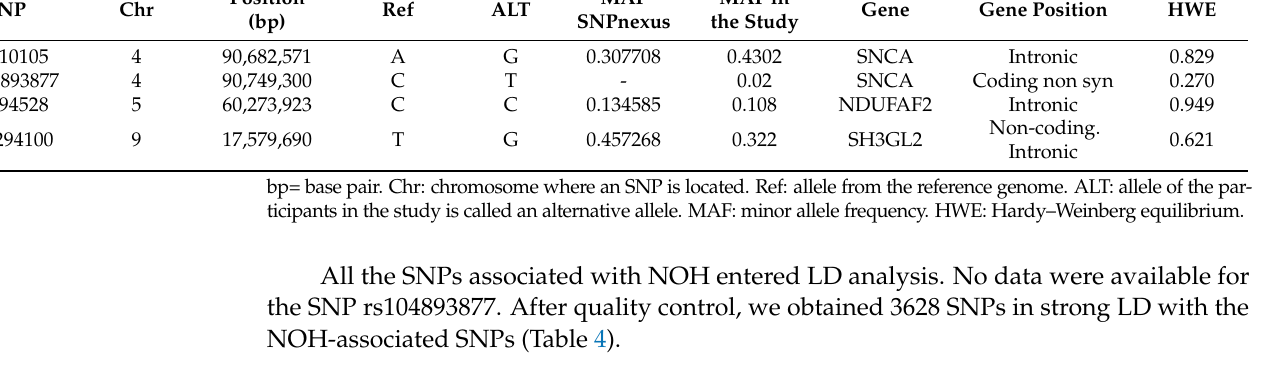
Table 4. Results of the linkage-disequilibrium-based gene expression